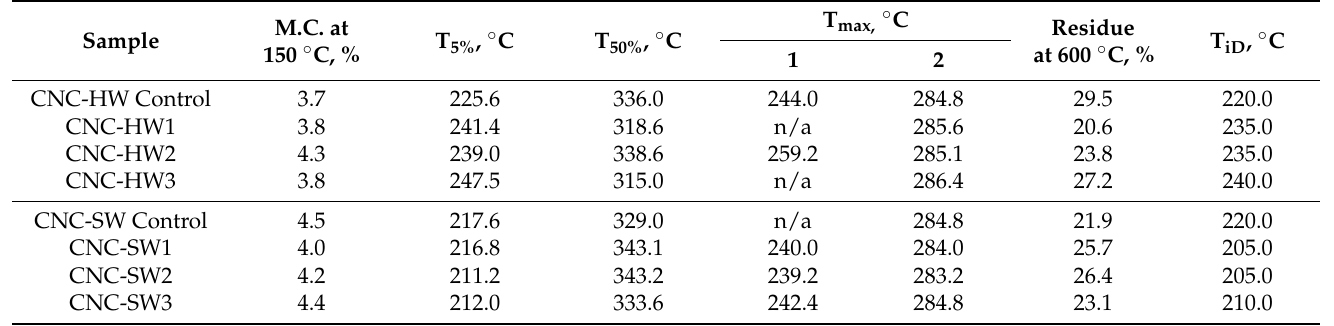
Table 8. Summary of TGA data of CNC